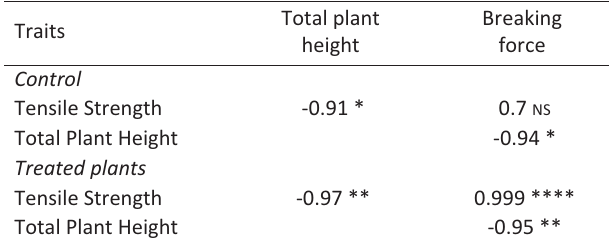
Asterisk indicates statistical significance, at P=0.12(NS), 0.033(*), 0.002(**) and <0.0001(****), NS = non significance